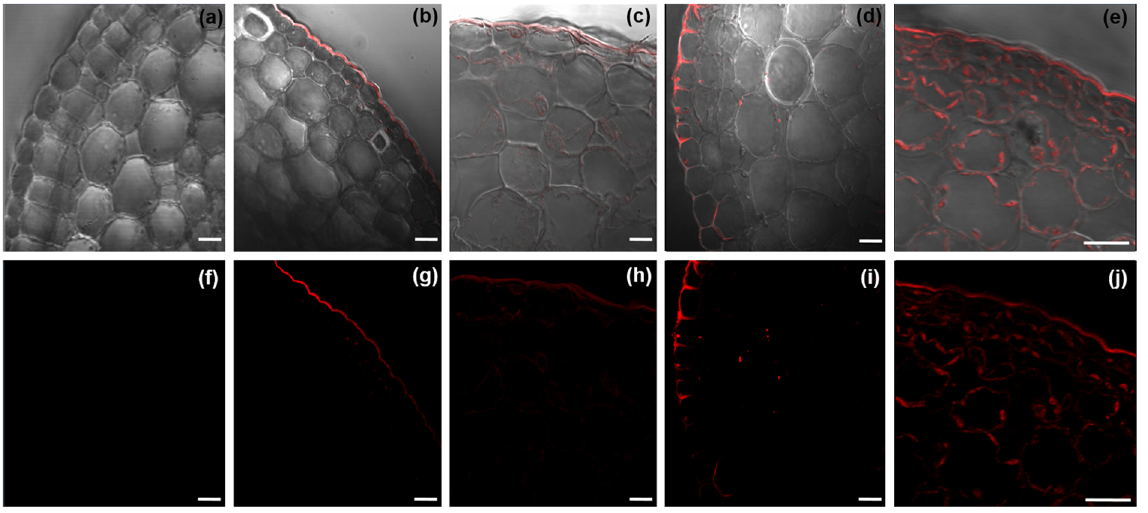
Figure 5. Identification of fluorescence at specific points in epidermis of stevia stems at 0, 25, 50, 100 and 200 mg L − 1 (light field and fluorescence field). ( a–e ) Clear field and ( f–j ) fluorescent field. Bar = 20 µ